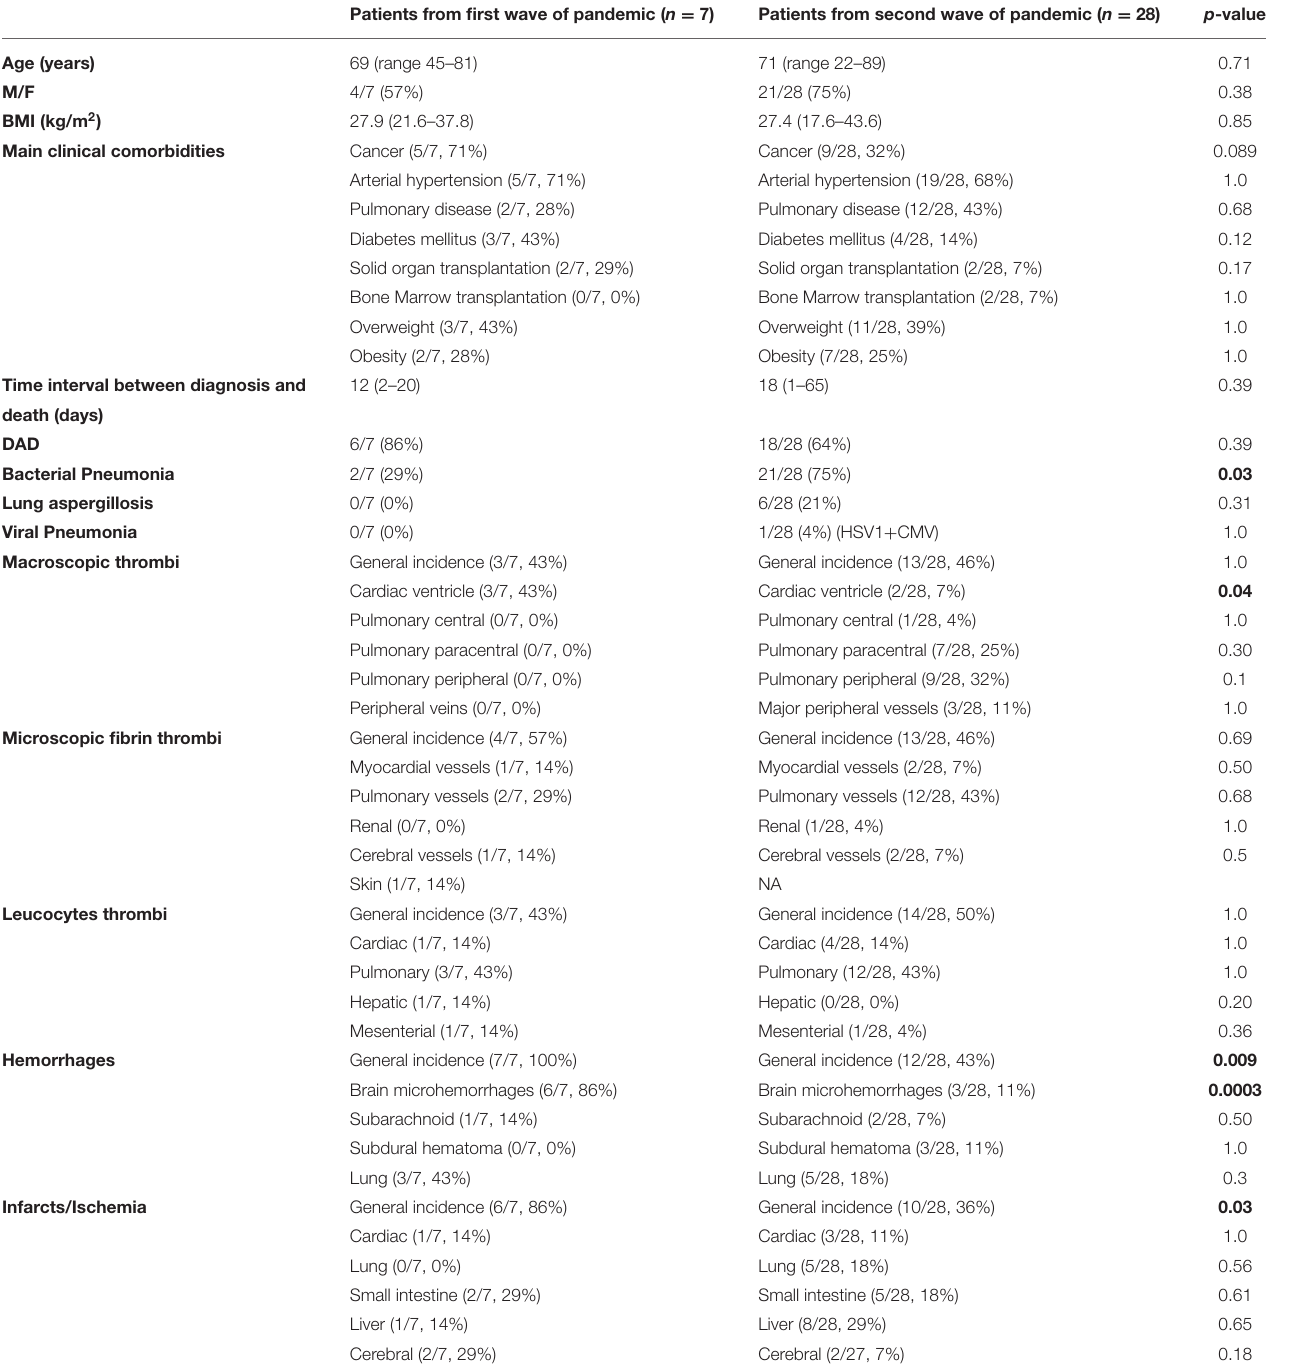
TABLE 1 | General characteristic, comparison of the two different cohorts (first vs. second wave) and detailed autopsies’ findings. Patients from first wave of pandemic ( n = 7) Patients from second wave of pandemic ( n =